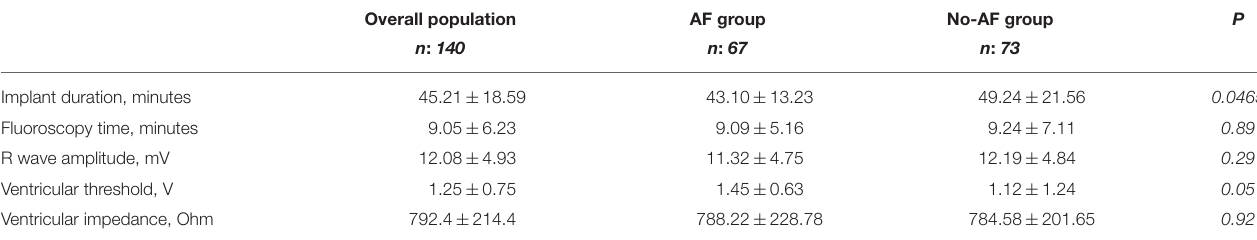
TABLE 2 | Intraoperative data and electrical parameters.